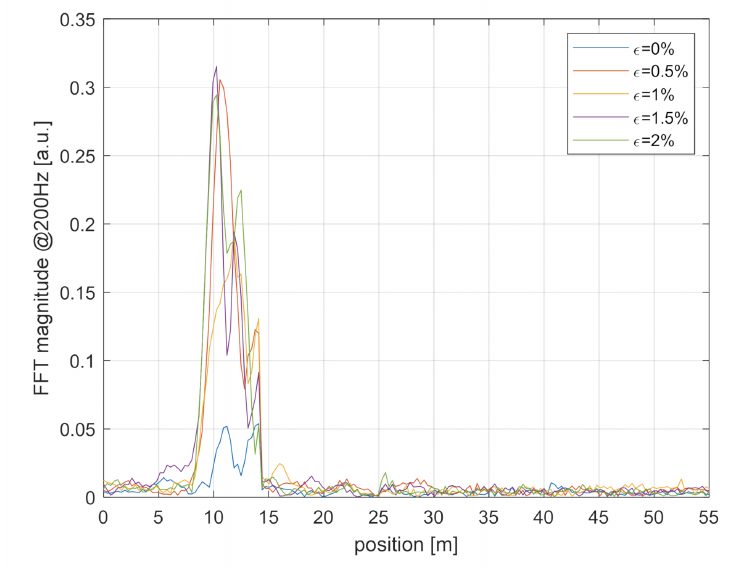
Figure 7. Magnitude of the 200-Hz tone in the acquired φ -OTDR signal, as a function of the position and for different static strain